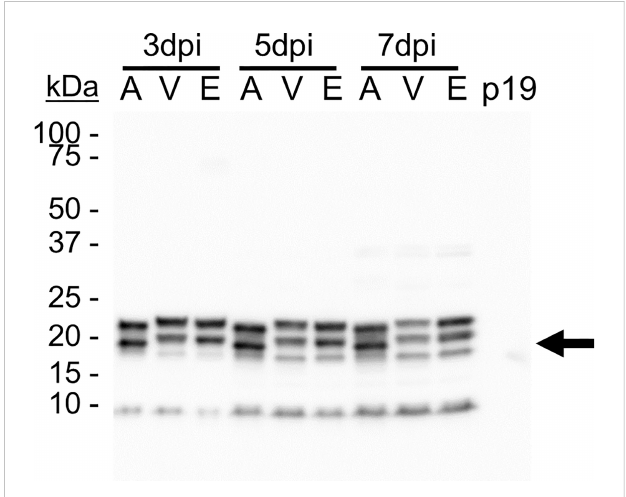
FIGURE 2 TMVc accumulates in the secretory pathway. Proteins were targeted to the apoplast (A), vacuole (V), and ER (E) and were sampled on 3, 5, and 7 days post-in fi ltration (dpi). The p19-in fi ltrated sample acts as a negative control. The black arrow denotes the expected size of unglycosylated TMVc monomer (19.9 kDa). Detection was performed using an anti-HA primary antibody at a 1:5000 dilution, and is representative of two transient expression experiments. In each lane 20 µl of total soluble protein were loaded, corresponding to approximately 6.67 mg of leaf fresh